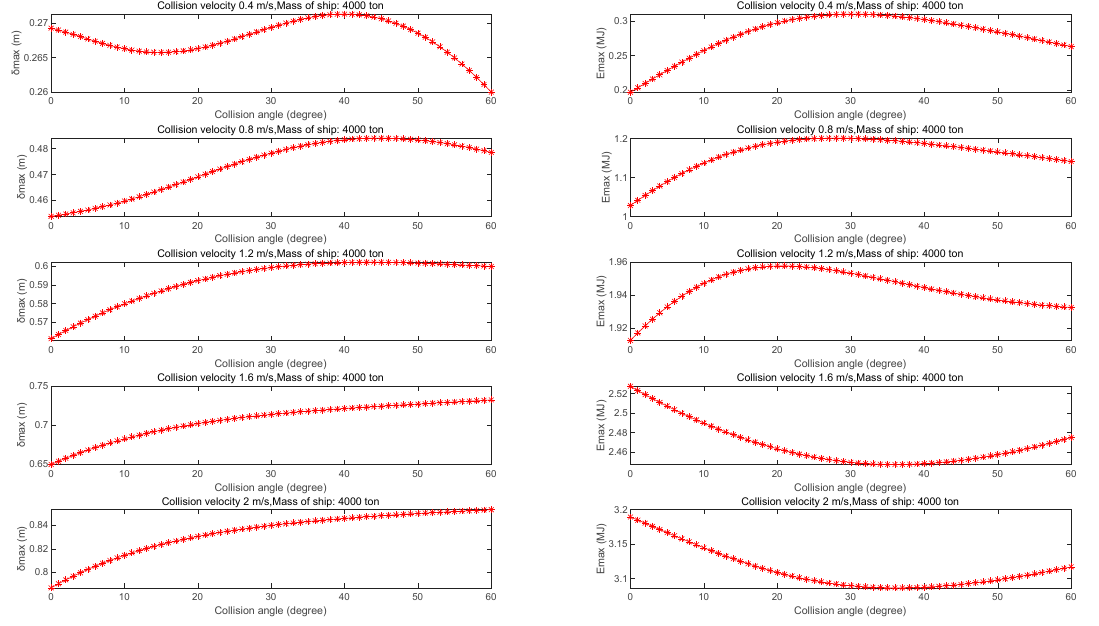
Figure 10. Curves of δ max and E max varying with the collision angle under 5 different collision velocities.